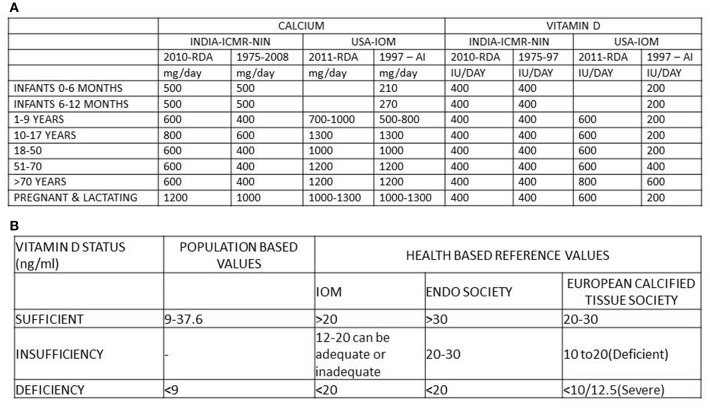
(A) RDA of calcium and vitamin D of India ICMR-NIN (27–29) and USA-IOM (31, 32)9. (B) Normal range of vitamin D from population based reference values, health based reference values (IOM & Endo. Soci). ICMR, Indian Council of Medical Research; NIN, National institute of nutrition; IOM, Institute of Medicine; Endo Soci, Endocrine society, USA; AI, adequate Intake; IU/day, International units/day; mg/day, milligram/day.